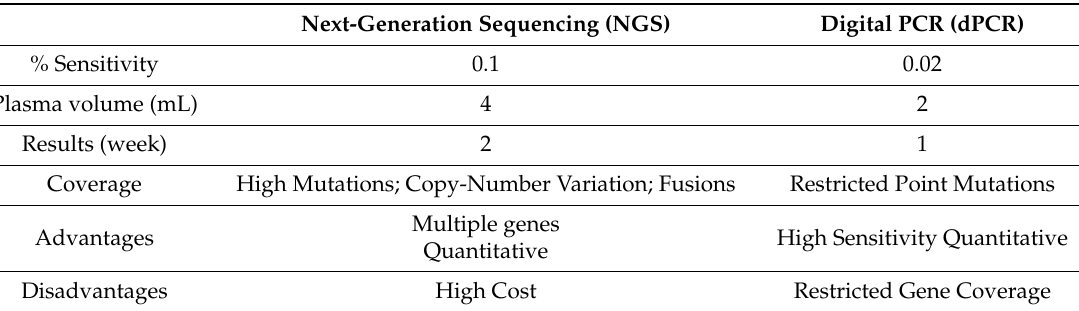
Table 2. Test properties to determine RAS in ctDNA in